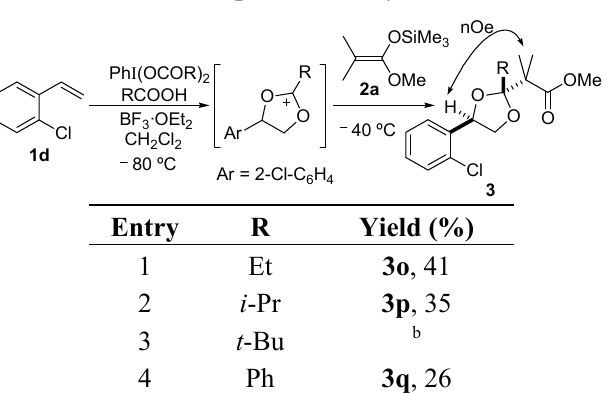
Table 3. Scope of carboxylic acids a